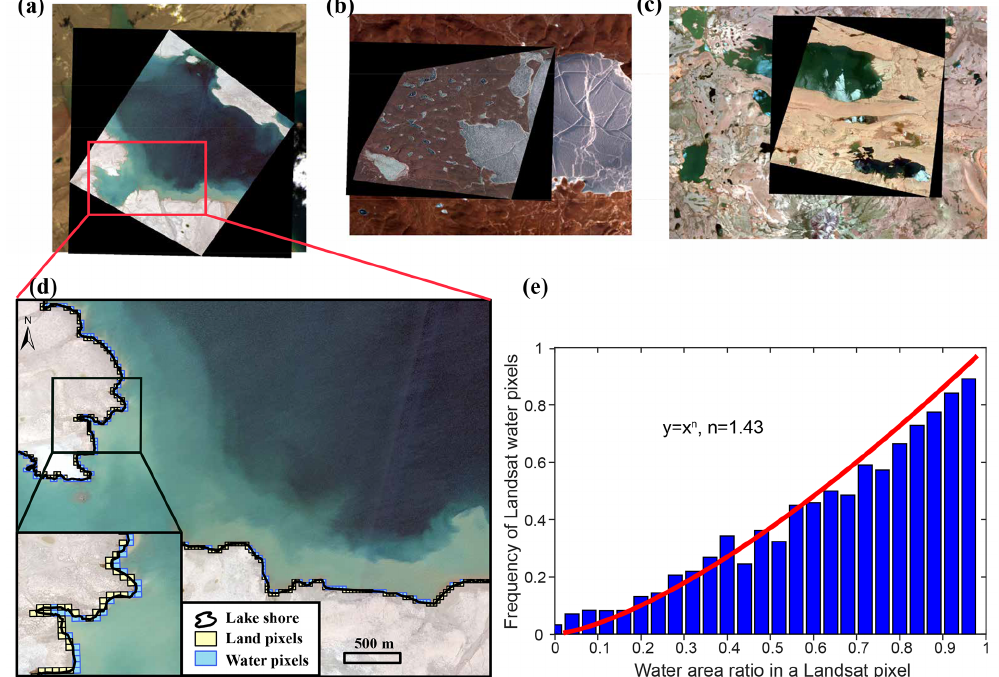
Figure 9. (a–c) GF-2 images (upper layer) and corresponding Landsat 8 OLI images (bottom layer) acquired on 7 September 2015, 29 Jan- uary 2016, and 5 July 2015; (d) Landsat 8 OLI shoreline pixels (the background is the GF-2 image) – blue pixels were classified as water, and yellow pixels were classified as land; (e) the relationship between the water area ratio in a pixel and the frequency of the pixel being classified as water. Blue bars are sampled at a 0.04 bin space from the 4128 pixels. The red line shows the fitting curve based on the maximum likelihood